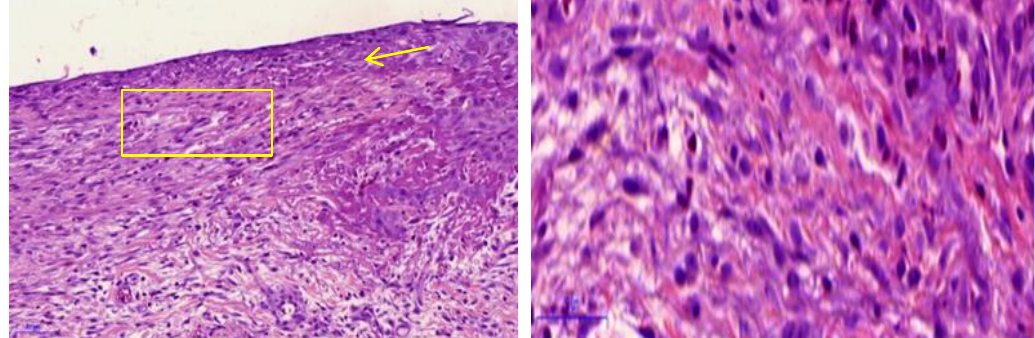
Figure 5: Microphotograph of study group treated with gingival sulcular irrigation of 50 μL/kg of distilled water after 14 days showing shows a mild inflammatory cell with still exhibited incomplete re- epithelization (arrow). H&E x20,x40